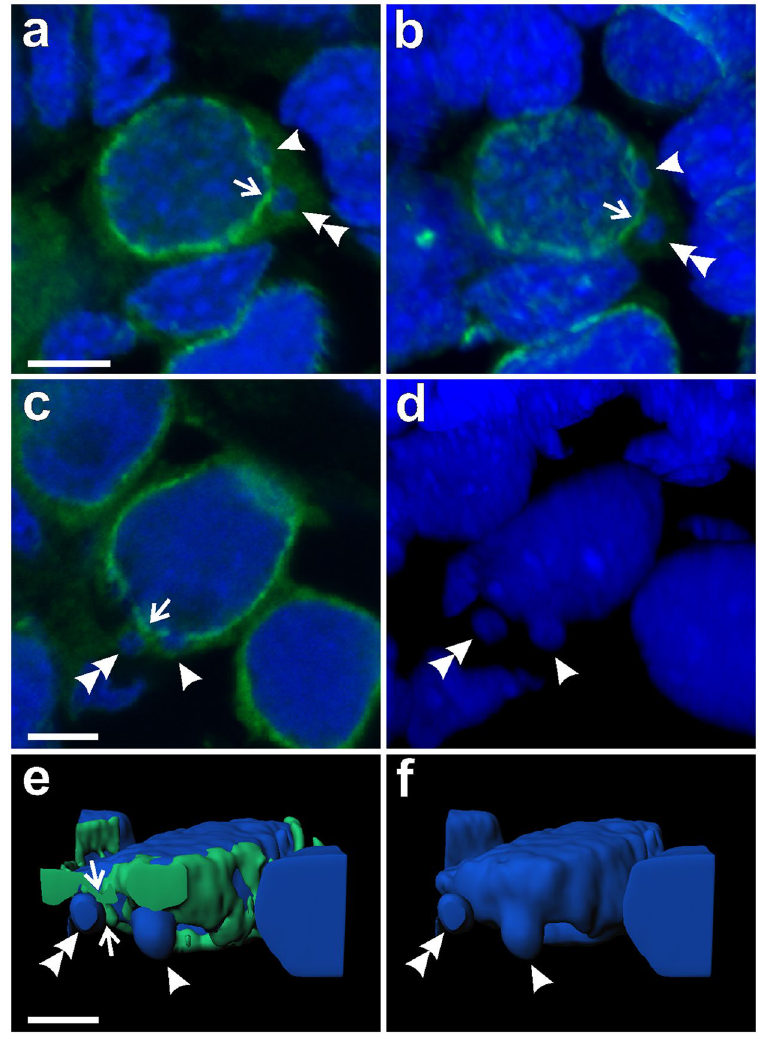
Figure 5. Formation of micronuclei from nuclear extrusions in gonocytes. Immunofluorescent staining of frozen tissue sections of ovaries from P. esculentus diploid females at 41 ( a,b ) and 44 ( c–f ) Gosner stages: nuclear pore complex proteins, NPC (Nup F/G, green), DNA counterstained with DAPI (blue). ( a–c ) Single confocal sections of DNA and NPC proteins (0.46 µ m). ( b,d ) 3D reconstructions of natural confocal sections showing the views of germ cells from the angle to visualise chromatin budding (arrowheads). ( e,f ) 3D models of reconstructed fluorescent signal volumes from cell visible in c,d , ( e ) NPC proteins and DNA, note that NPC signal is discontinuous probably due to differential distribution of nuclear pore complexes in the nuclear envelope and threshold settings excluding cytoplasmic signal, ( f ) DNA. ( a,b ) Early stage of micronucleus formation: gonocyte with small chromatin extrusion possessing a weak NPC protein signal in nuclear envelope and strong DAPI signal (arrowhead), representing emerging micronucleus containing heterochromatin. Second micronucleus with punctate NPC protein signal (a, arrowhead). ( c,d,f ) Middle stage of micronucleus formation: extruded chromatin has finger-like shape and is connected with main chromatin mass in the cell nucleus (arrowhead). Note the discontinuous NPC signal in the nuclear envelope at budding site. Late stage: micronuclei (double arrowhead, a–e) are separated from the main nucleus by nuclear envelope with strong NPC protein signal (arrow), either protruding towards the micronucleus ( a ) or flat (c,e). There is no distinct NPC protein signal at the nuclear envelope in micronucleus ( c ) as well as in finger-like extrusion (arrow, c,e). Scale bars 5 µ